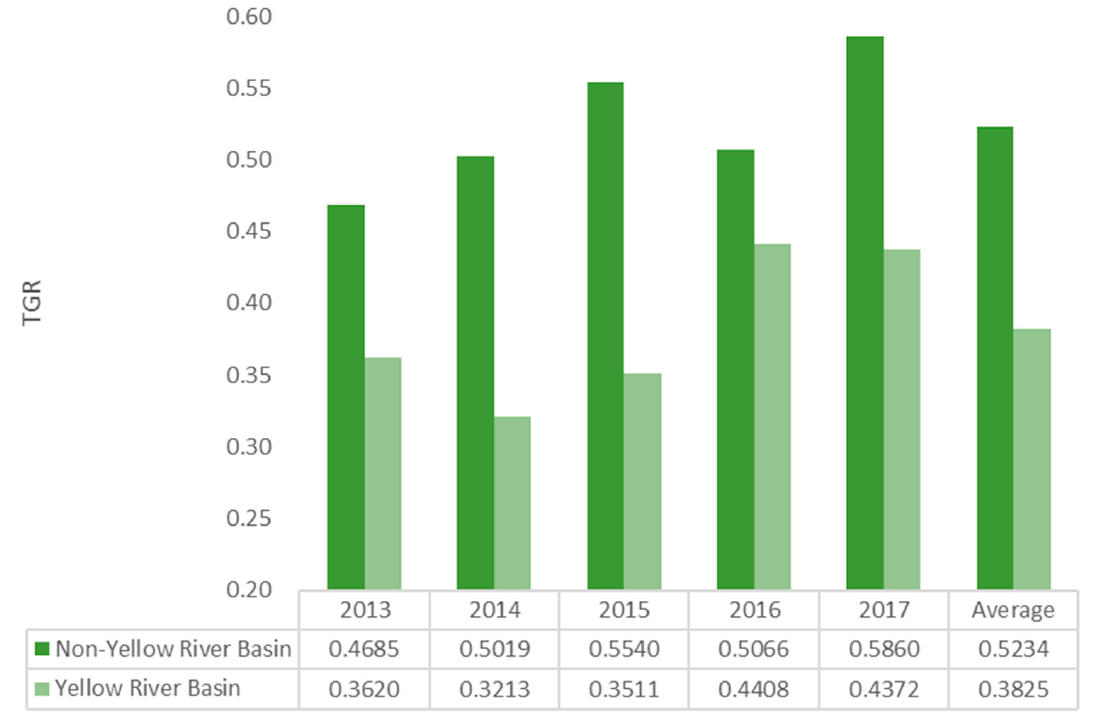
Figure 5. TGR analysis of the Yellow River and Non-Yellow River basins from 2013 to 2017. Based on the combined analysis of DDF efficiency and TGR results of the Yellow River and Non-Yellow River basins from 2003 to 2007 (Figure 6), the overall efficiency performance of the two regions has little change during the study period. Among them, the Yellow River Basin was only slightly better than the Non-Yellow River basin (0.9863) in 2013 (0.9741), but in the TGR part, the performance of the two regions still has room for significant improvement. Among them, the TGR of the Yellow River Basin is significantly behind the Non-Yellow River Basin. Through reasonable human and capital allocation, we can implement the use of pollution prevention and control funds, and improve the technical level of industrial production to improve pollutant emission and increase output value, to improve the overall efficiency